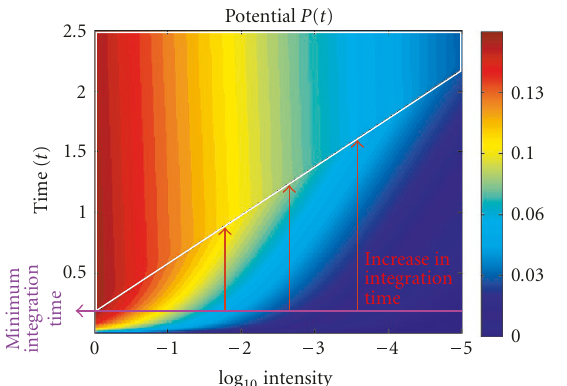
Figure 5: Dynamics of the “switching” gain control : the same as in Figure 4, but here the dynamics of the signal amplification variable G ( t , L ) (4) is visualized. The bright (dark) area on the bottom (top) indicates where the gain control is switched on (o ff ). Notice that the switching occurs rather fast around the red area. The switching area resembles a blurred line—compare it to the diagonal line delineat- ing the convergence plateau in Figure